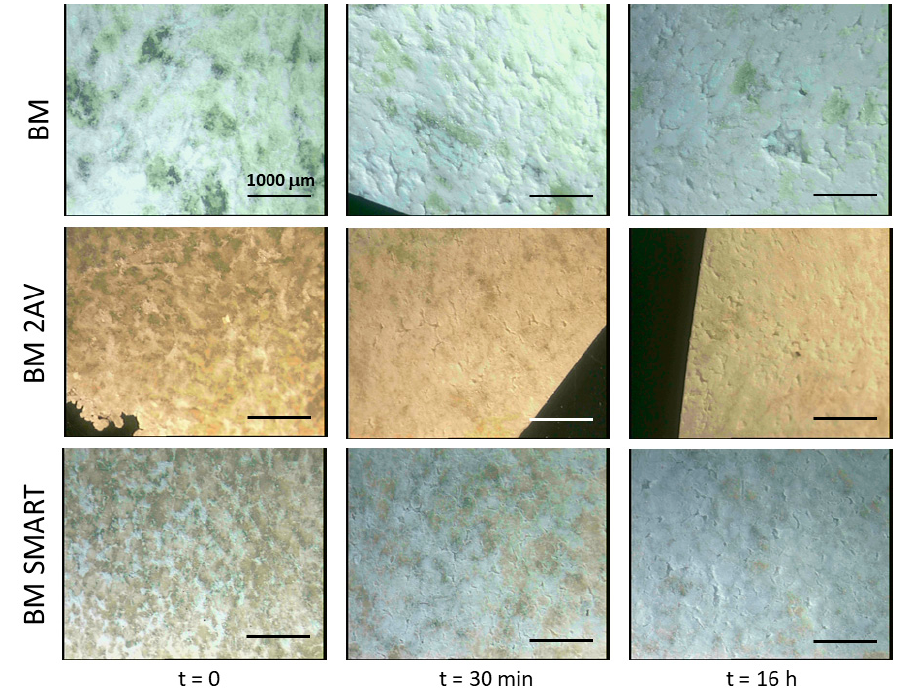
Figure 5. Stereomicroscopy images of films before and after immersion in water for 30 min and 16 h. Magnification is 6.4 × .